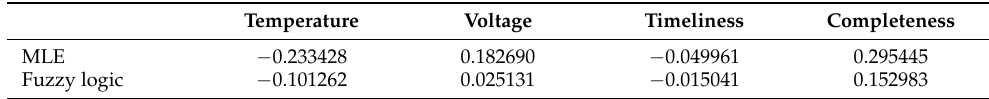
Table 6. Pearson’s correlation coefficients between data quality indicators, measured values, and data quality attributes of Intel Lab